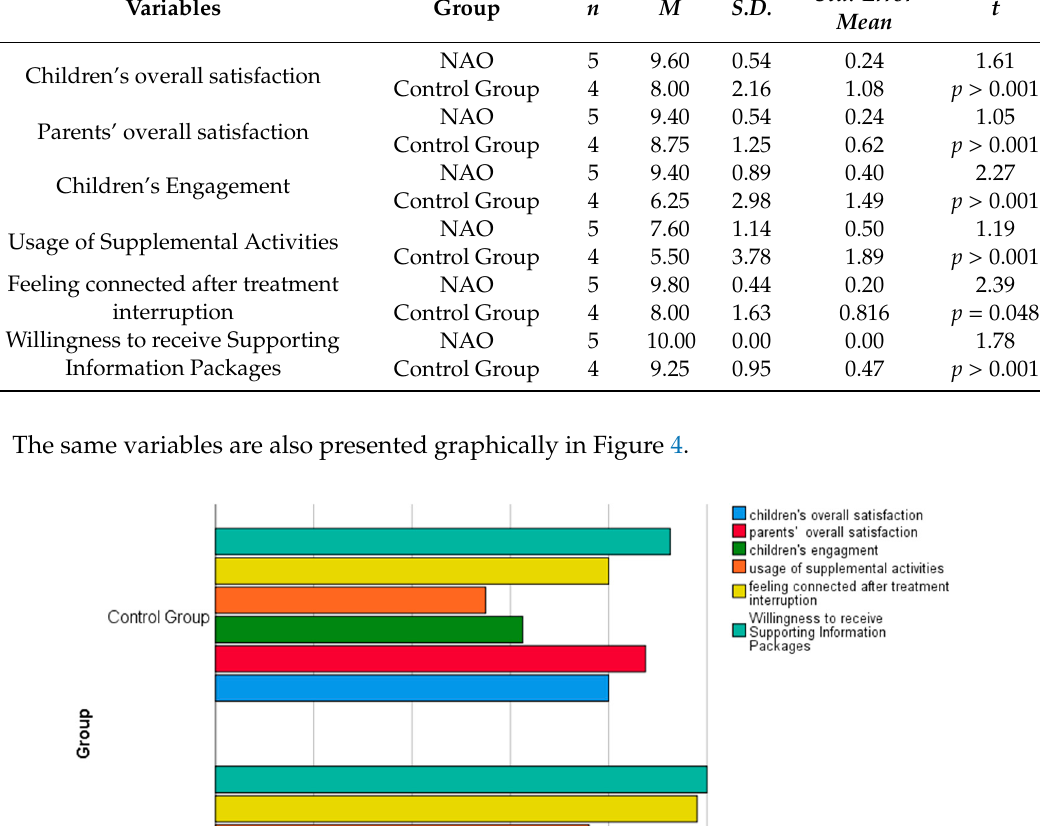
Table 3. Means and standard deviations.